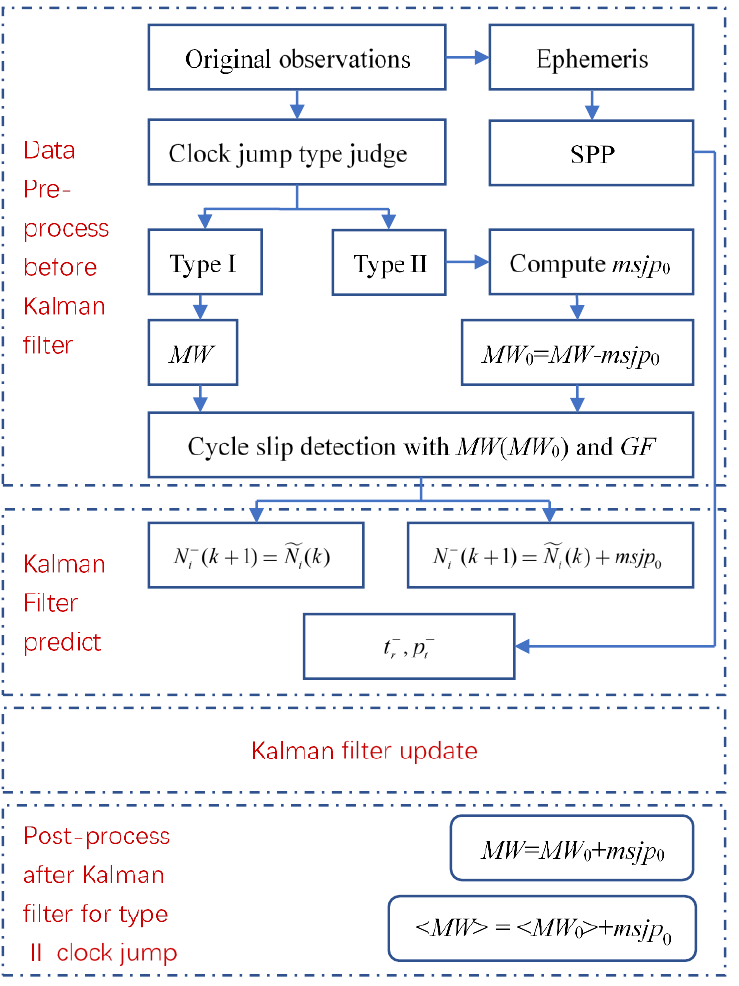
Figure 4. Clock jump handling in PPP.